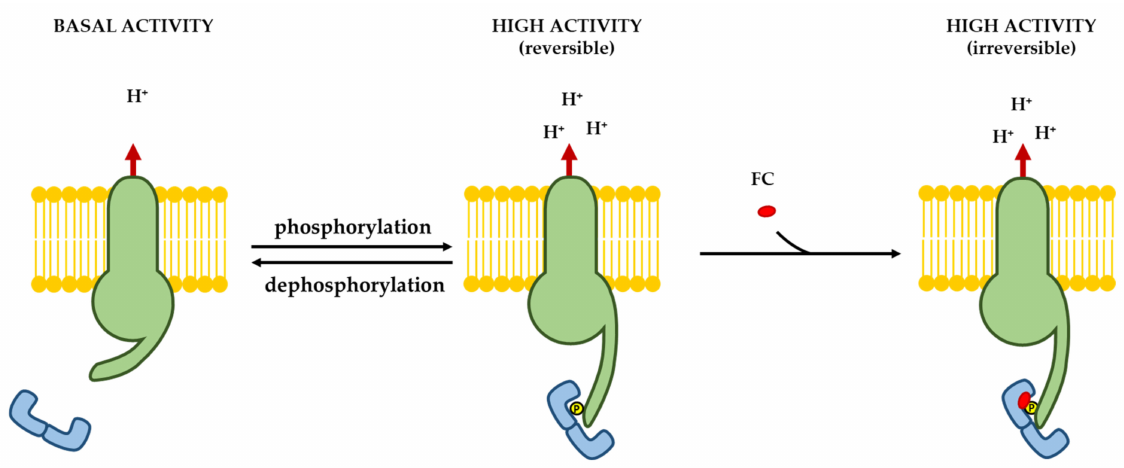
Figure 9. Activation of the plasma membrane H + -ATPase by 14-3-3 proteins and FC. Phosphorylation of the C-terminal penultimate Thr residue (Thr947 in the Arabidopsis H + -ATPase AHA2 isoform) generates a 14-3-3 binding site. Association of 14-3-3 proteins leads to the displacement of the C terminus of the proton pump and consequently to its activation. FC greatly stabilizes the interaction, causing irreversible activation of the H +